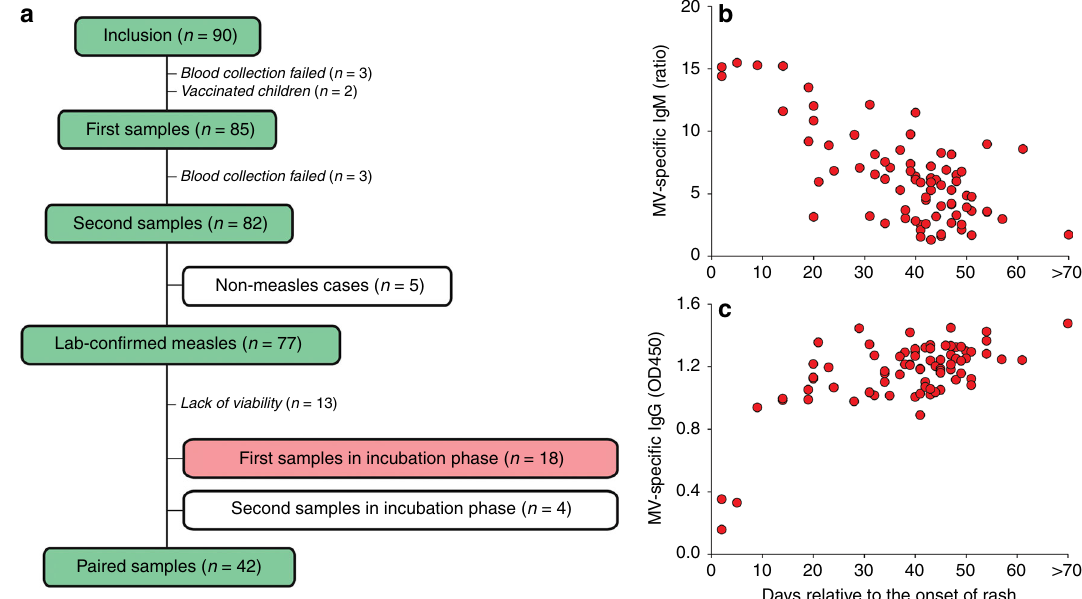
Fig. 4 Cohort B patient information. a Number of inclusions and number of laboratory-con fi rmed measles and non-measles samples collected before and after the measles outbreak. White box indicates samples not included in measurement. Red box indicates samples included in the identi fi cation of MV- infected cells. b The levels of MV-speci fi c IgM and c IgG in plasma of each Cohort B child relative to the onset of rash ( n = 77 donors). Each red